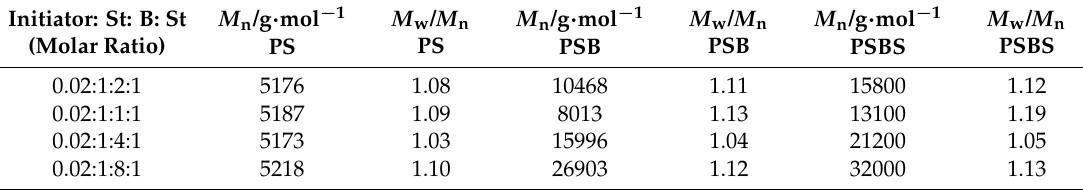
Table 2. Molecular weight data of every polymerization